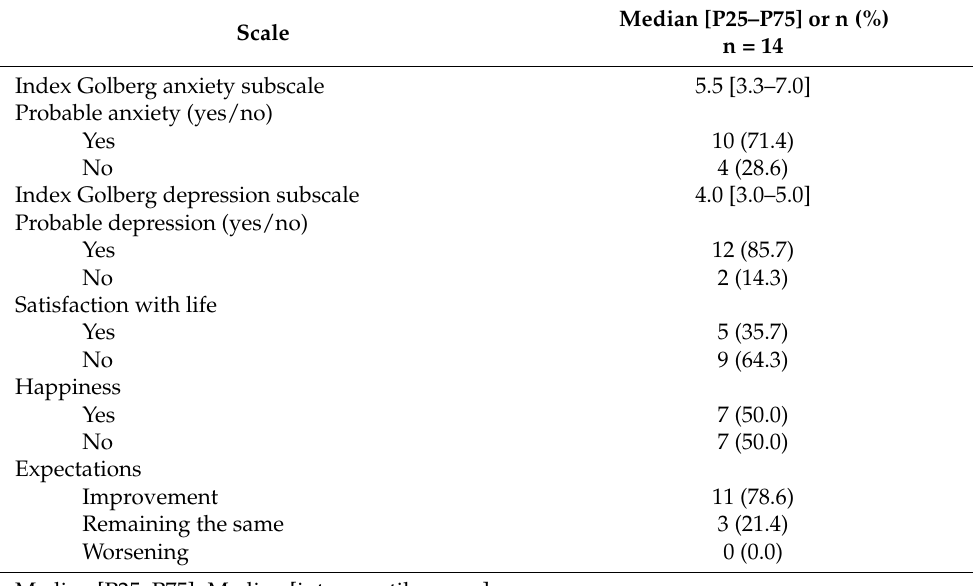
Table 3. Descriptive analysis of the scales of anxiety, depression, satisfaction with life, happiness, and responses on future expectations.